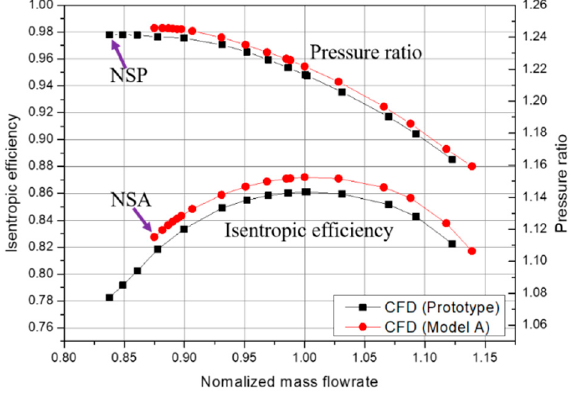
Figure 11. Performance in the whole operating range.